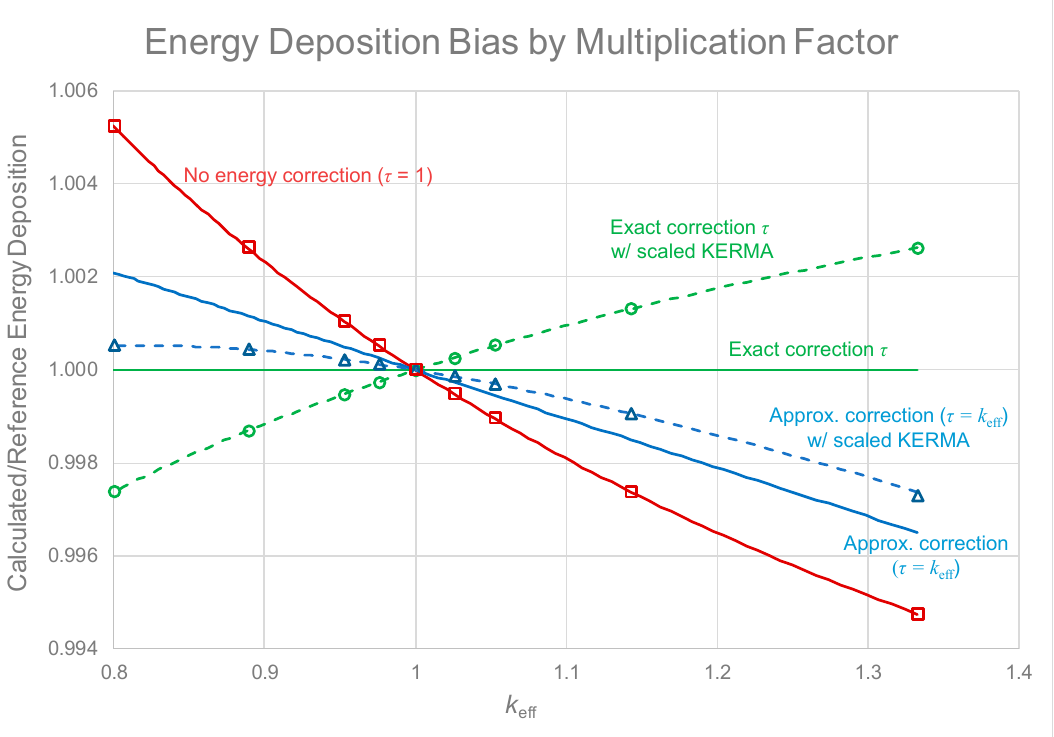
Figure 2. Energy deposition bias as a function of multiplication factor for an infinite, homogeneous, two-nuclide test problem. Theoretical results are provided for three energy correction schemes (no correction, approximate, and exact), and for reference (solid lines) and scaled KERMA values (dashed lines). Corresponding numerical results from an MC21 calculation are shown as open markers for selected conditions.